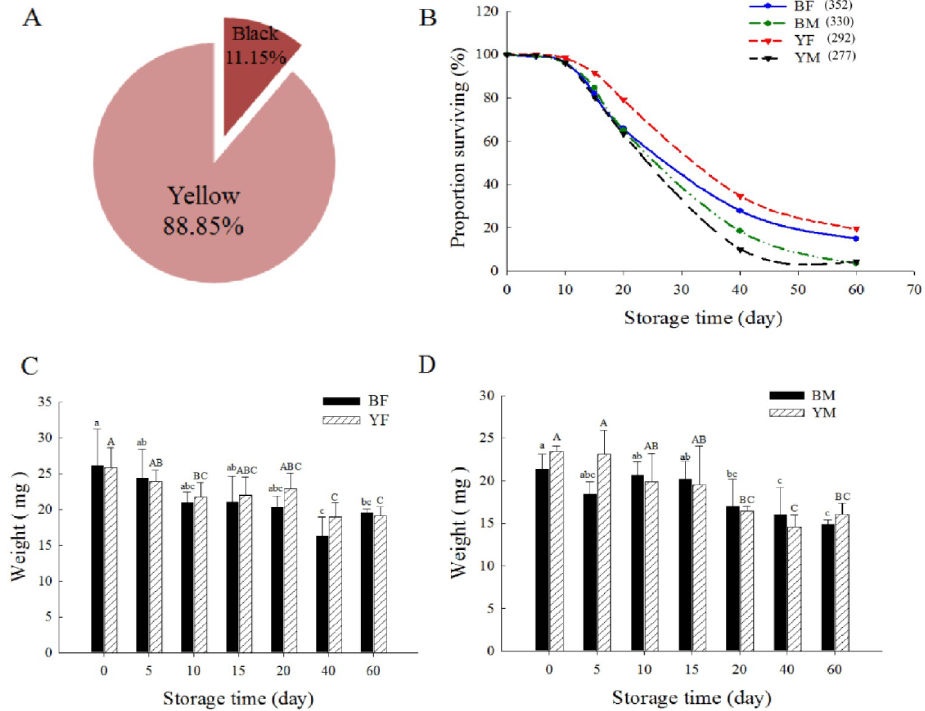
Fig 1. Elytral colour, surviving (%), and weight of pre-wintering H . axyridis . (A) The proportion of yellow and black individuals in late September and early October of each year from 2013 to 2015. (B) Survival of yellow (YF, Sample size: 292) and black females (BF, Sample size: 352) and yellow (YM, Sample size: 277) and black males (BM, Sample size: 330). (C) Weight of females, and (D) weight of males at different periods under low temperature storage. Each bar depicts the mean (+ SD) of three sampling dates, with different letters above the error bars denoting significant differences between means (Tukey’s test, α = 0.05; each group was analysed separately).